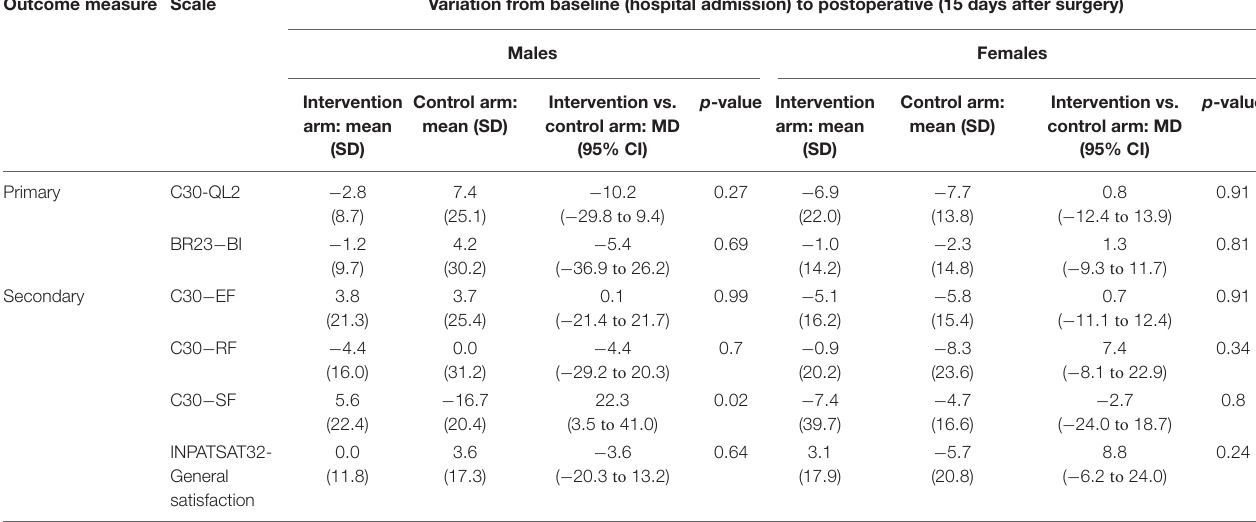
APPENDIX TABLE 1 | Primary and secondary outcome measures stratified by sex: variation from baseline (hospital admission) to postoperative (15 days after surgery). Outcome measure